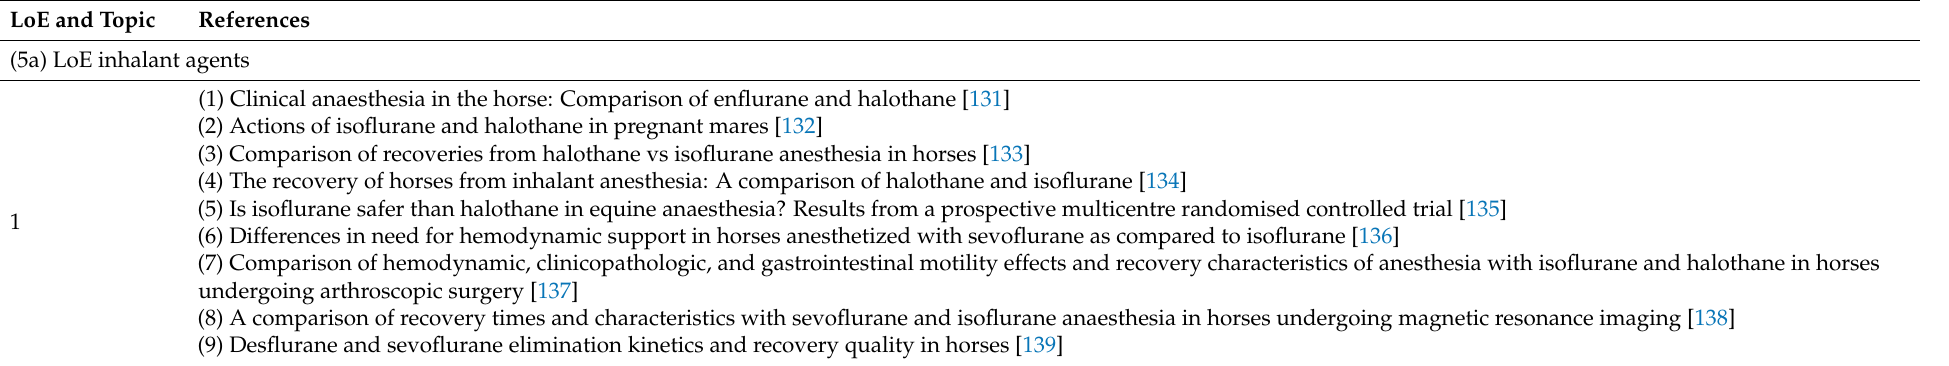
Table 5. Total of publications giving information about the effects of (5a) “maintenance with inhalant agents”, (5b) “maintenance with total intravenous anaesthesia (TIVA)” and (5c) “maintenance with TIVA versus inhalant agents” on the recovery